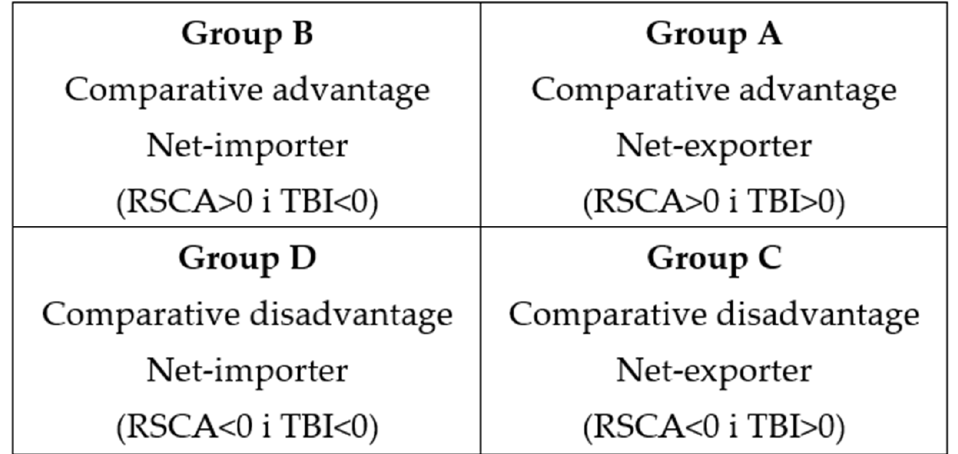
Figure 1. Mapping of products depending on the level of comparative advantages and the degree of export specialization according to Widodo. Source: Widodo [74].